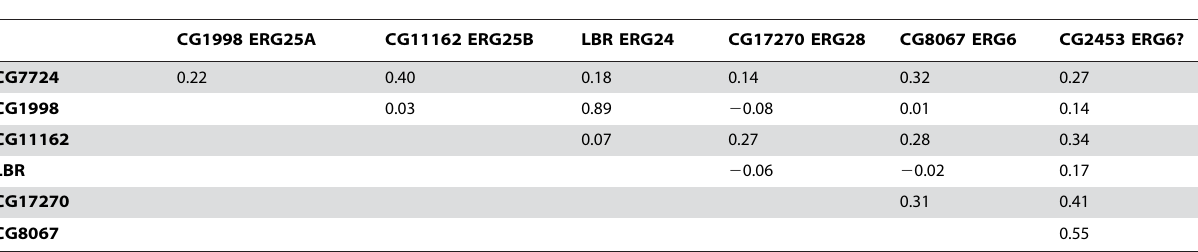
Table 3. Expressional correlation among D. melanogaster ERG